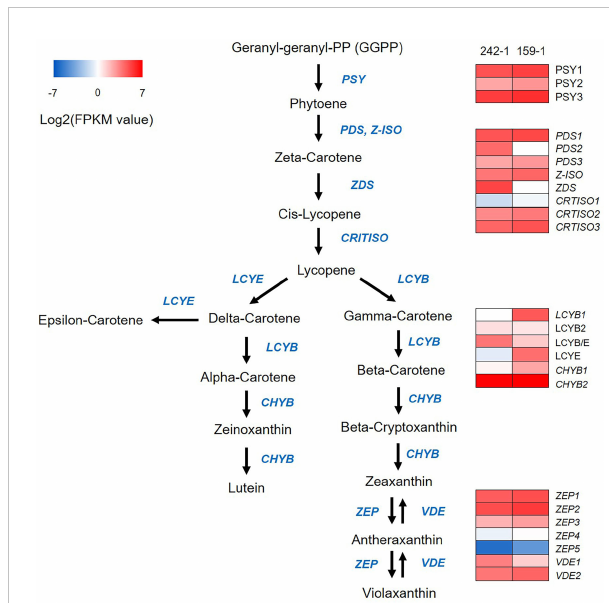
FIGURE 3 A heatmap diagram of expression levels of carotenoid biosynthetic pathway genes identi fi ed by KEGG analysis. The heatmap was drawn according to FPKM values calculated from Illumina short-read transcripts. Columns and rows in the heatmap represent samples and genes, respectively. Sample names are displayed above the heatmap. Color scale indicates fold changes in gene expression. PSY, phytoene synthase; PDS, phytoene desaturase; Z-ISO, zeta- carotene isomerase; CRTISO, beta-carotene isomerase; LCYB, lycopene beta-cyclase; LCYB/E, lycopene beta/epsilon